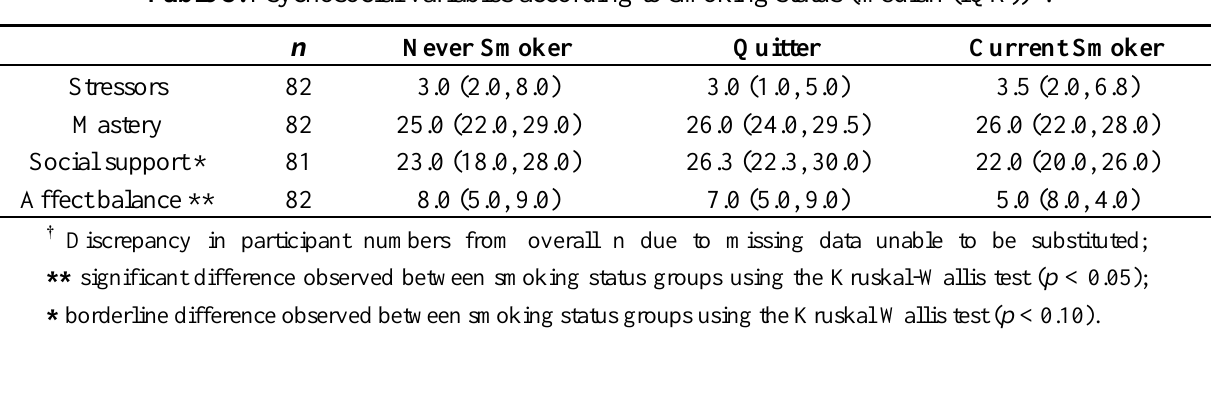
Table 3. Psychosocial variables according to smoking status (median (IQR)) †